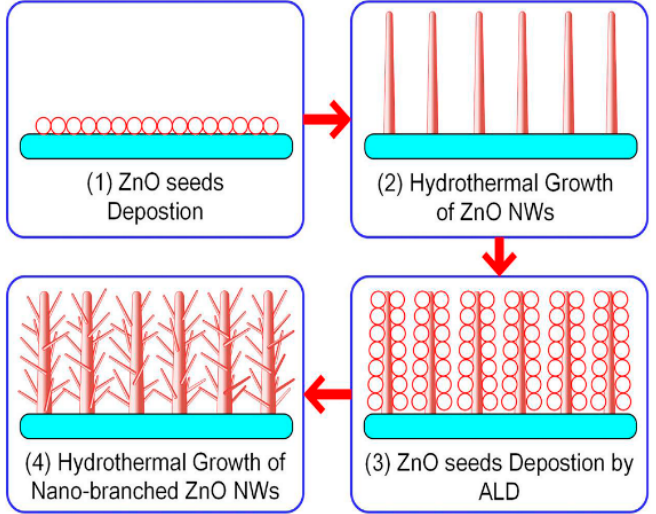
Figure 18. The growth process of ZnO nanowire [83].